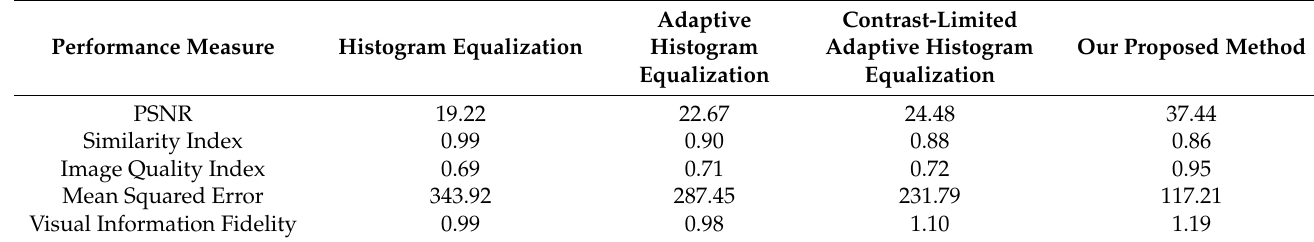
Table 1. Numerical results of contrast enhancement.